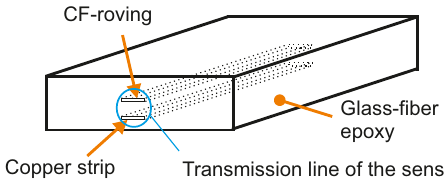
Figure 1. Schematic setup of the carbon fibre strain sensor showing the realization of the microstrip line embedded in a carrier